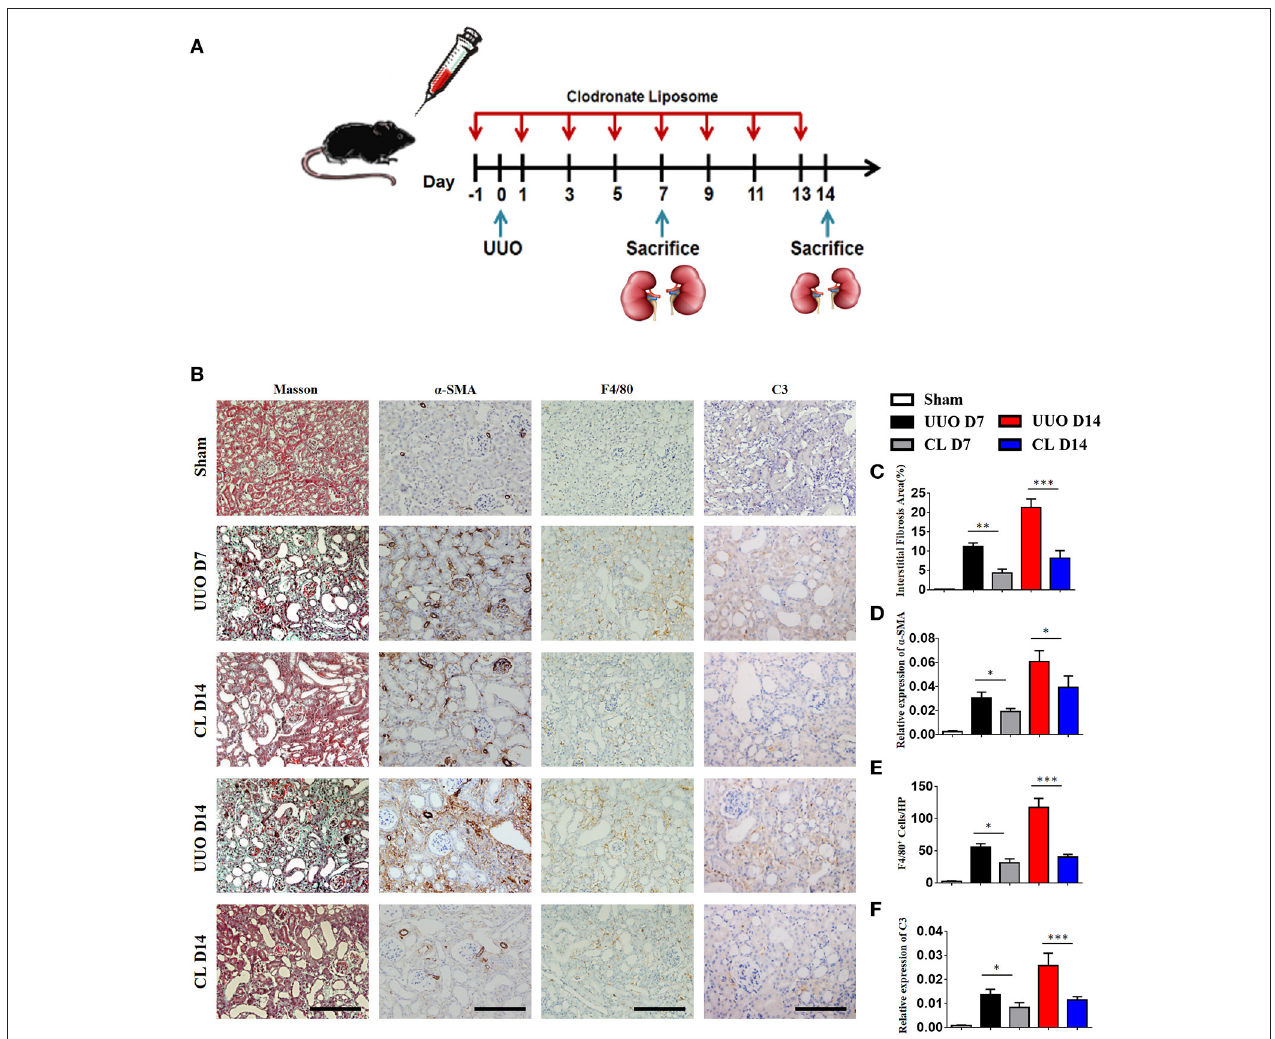
FIGURE 4 | Macrophage depletion protects against renal fibrosis by inhibiting C3 expression. UUO mice were intravenously injected with clodronate liposomes and control liposomes. On days 7 and 14, mice were sacrificed, and the left kidneys were collected. (A) Scheme of clodronate liposome-mediated macrophage depletion. (B) Masson’s trichrome staining indicates collagen deposition. IHC staining showing α -SMA, F4/80, and C3 protein expression in these groups ( n = 6); original magnification, × 400. Scale bar, 50 µ m. Quantitative analysis of interstitial fibrosis (C) , a-SMA (D) , F4/80 (E), and C3 (F) positive cells were shown as mean ± SEM. * P < 0.05; ** P < 0.01; *** P <